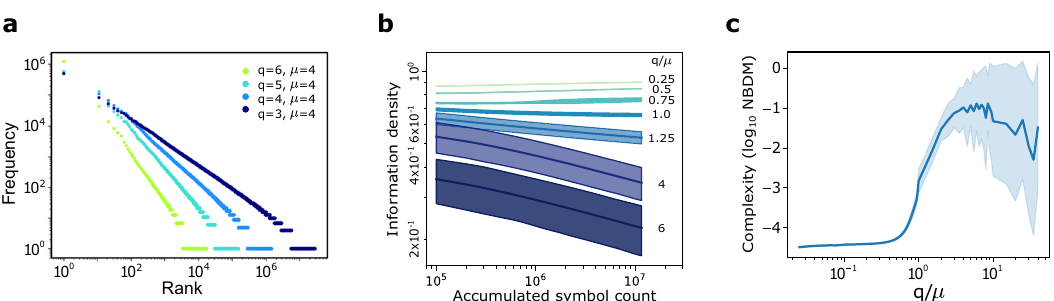
Fig. 3 Polya urn prediction of multi-scale diversity. a Rank-frequency distribution of components follows a power-law f ( R ) ~ R − α with an exponent α ≈ q / μ . Cultural products generated by urns with higher levels of imitation have steeper frequency rank distributions and so are less diversi fi ed. b When there is more imitation, synthetic histories become more compressible. We illustrate how the information density ρ ( n ) increases when additional symbols are gathered for different values of q and μ . The solid line indicates the average information density in synthetic cultural histories, ρ , while the shaded region contains one standard deviation of the sample. c The plot of average log-transformed structural complexity (NBDM) as a function of the ratio q / μ demonstrates how imitation results in simpler networks. Solid line marks the average complexity for 10 replicates of each pair, q ∈ [1, 40], μ ∈ [1, 40], plotted with logarithmic binning for the q / μ ratio. Shaded area represents 1 standard deviation of the sample. In each panel, simulated data comprise 10 independent synthetic cultural histories of 1000 products each, using different values of the urn parameters ( q , μ ) and the video game Pac-Man as a template.